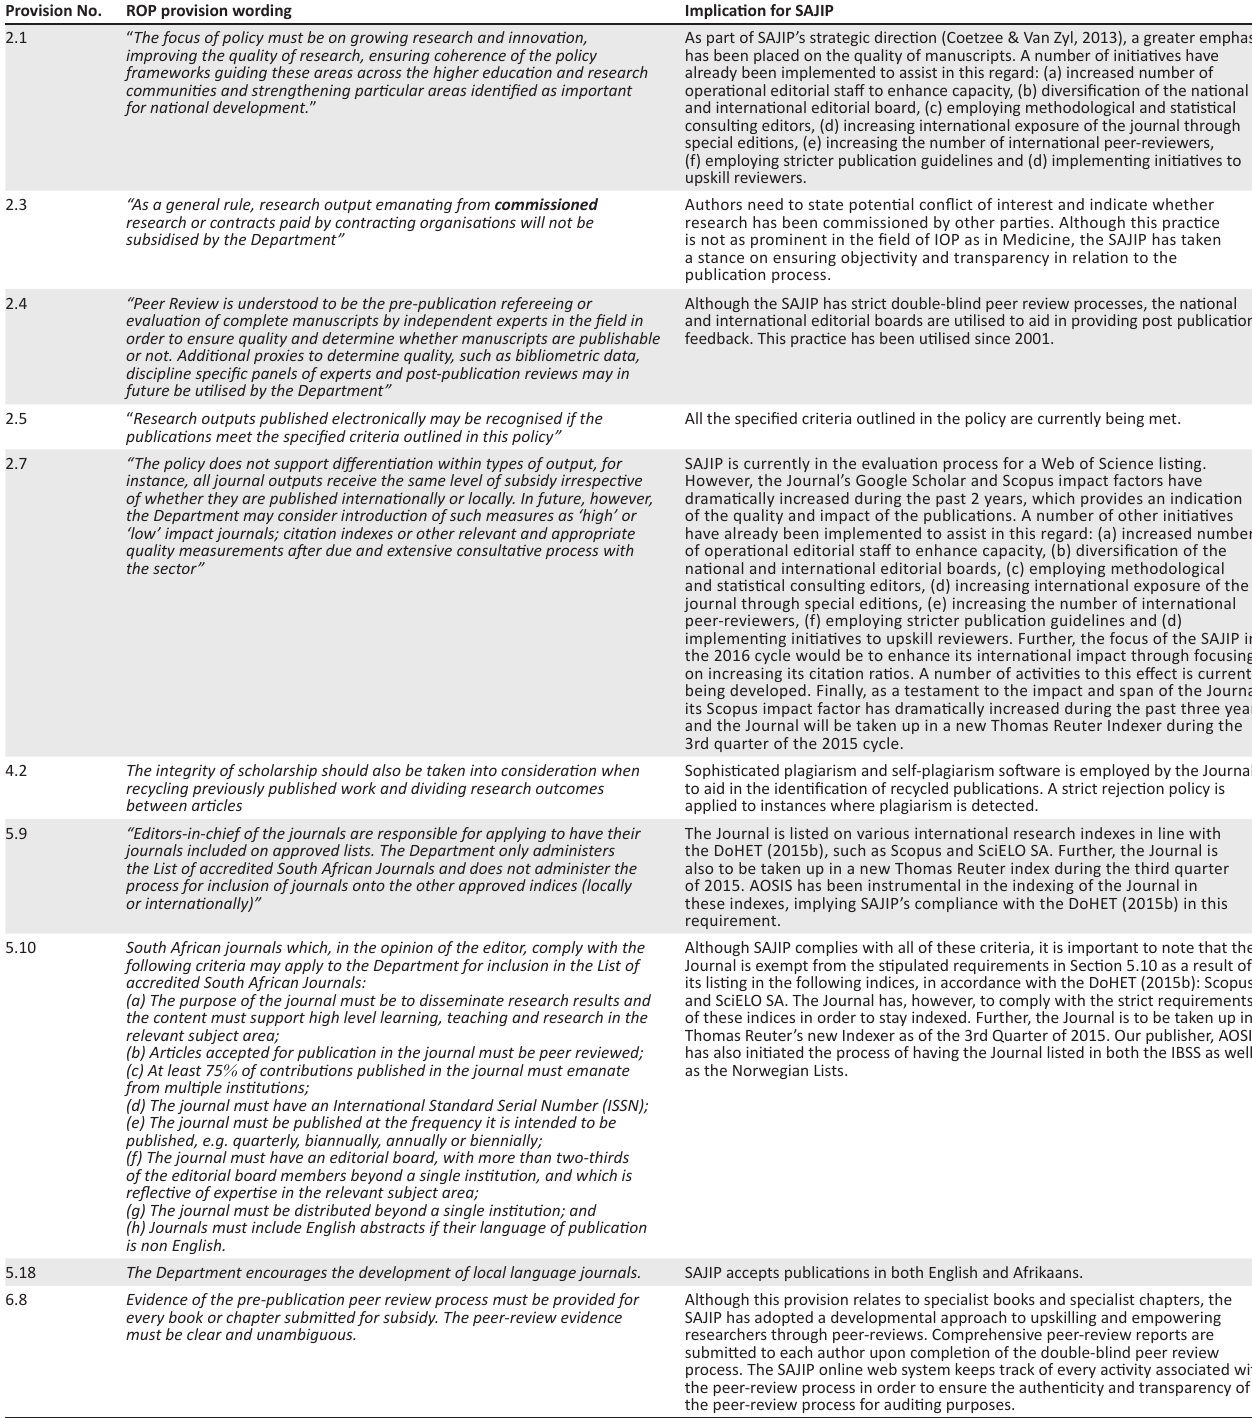
TABLE 4. Provisions of the DoHET Research Output Policy (2015a): Implications for